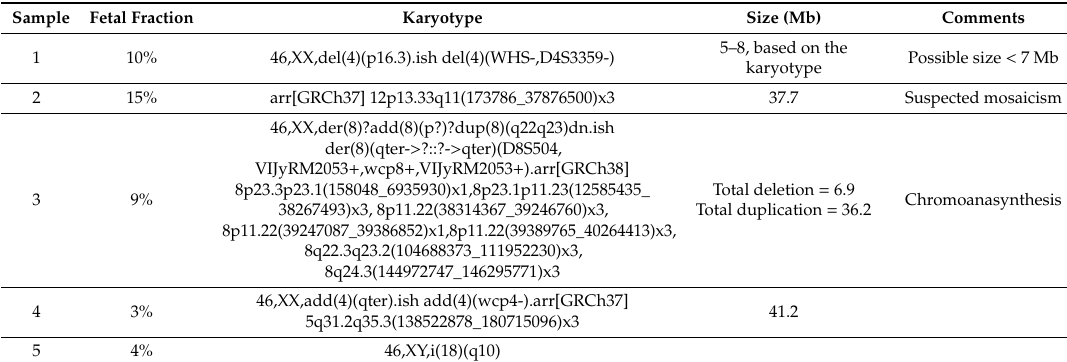
Table 1. Overview of the five false-negative samples from Cohort